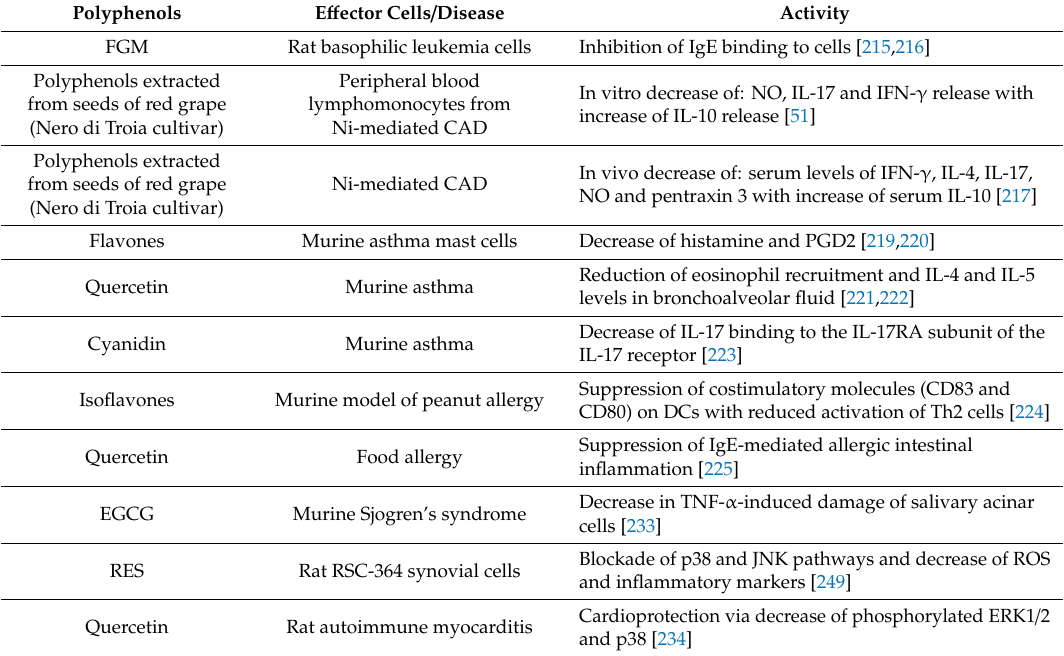
Table 7. E ff ects of grape polyphenols on allergy and autoimmune diseases.